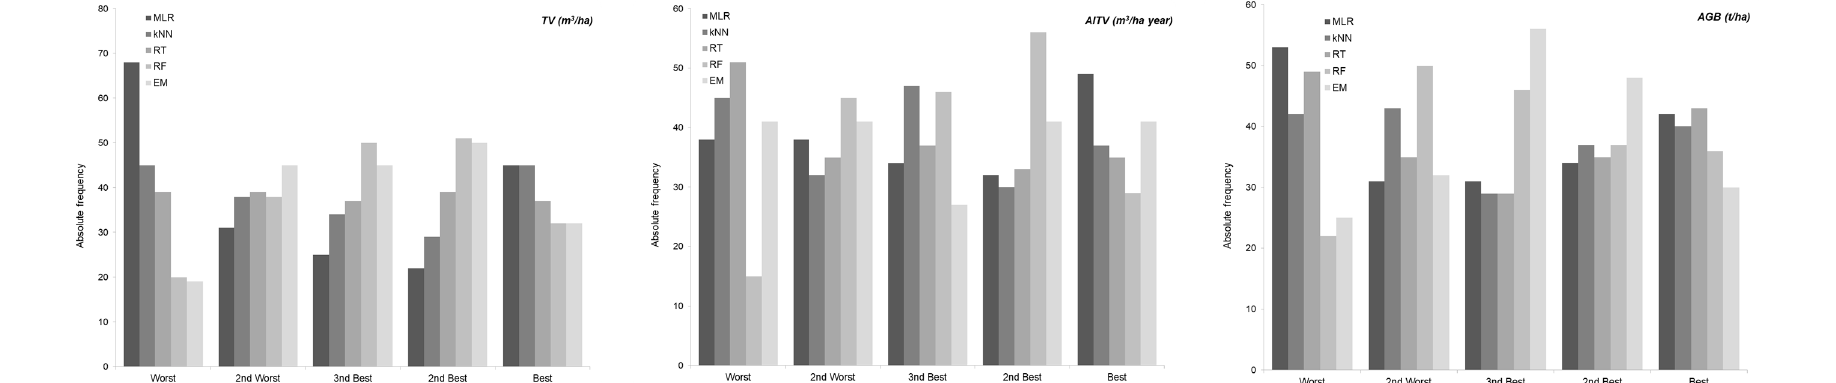
Figure 3. Absolute frequency of relative position achieved (percentile rank) by each technique with the best parameterization for total volume (m 3 / ha), annual increase in total volume (m 3 / ha year) and total aboveground biomass (t / ha) in E. globulus (row 1), P. pinaster (row 2) and P. radiata (row 3).